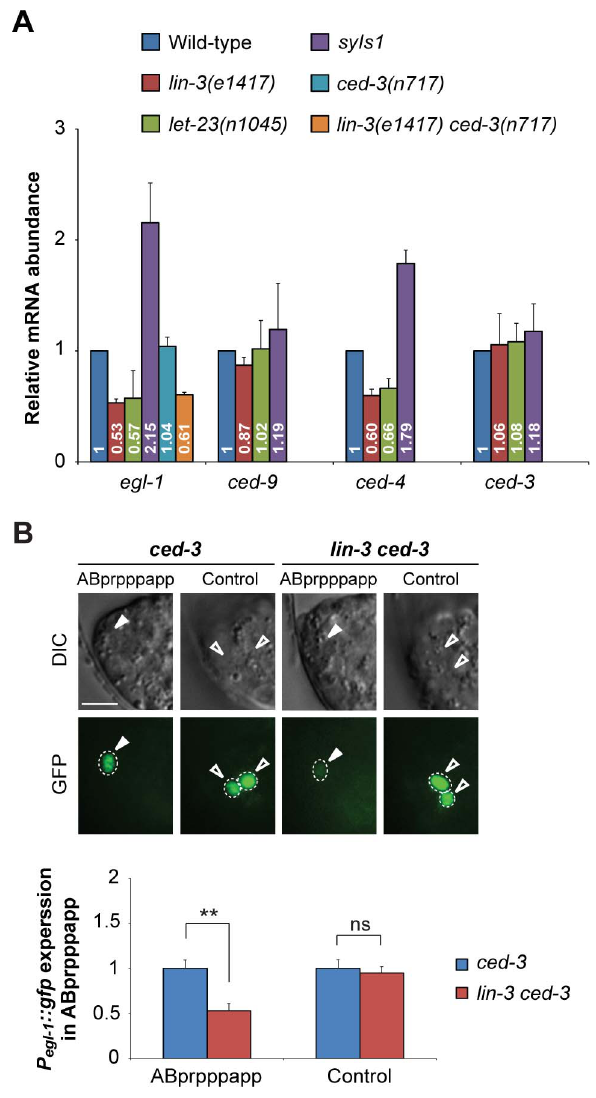
Figure 4. lin-3 promotes egl-1 transcription. (A) egl-1 , ced-9 , ced-4 , and ced-3 transcripts in embryos of indicated genotypes were measured by quantitative RT-PCR. The relative mRNA abundance is shown as the mean and SD of the results from at least two independent experiments, each performed in triplicates. (B) The DIC and GFP images of ced-3 (left) and lin-3 ced-3 (right) embryos expressing the P egl-1 ::gfp transgene. Arrowheads indicate ABprpppapp, and hollow arrowheads indicate two cells that also express egl-1 near ABprpppapp (Control experiment). The bottom figures show the P egl-1 ::gfp expression level of the indicated cells in the ced-3 single mutant (blue) and the lin-3 ced-3 double mutant (red). The expression level of P egl-1 ::gfp in ABprpppapp of ced-3(n717) (n=44) and lin-3(e1417) ced-3(n717) (n=40) mutants was analyzed as described in Materials and Methods. Error bars represent the SEM. **indicates P , 0.001 (two-tailed t test). Scale bar: 5 m